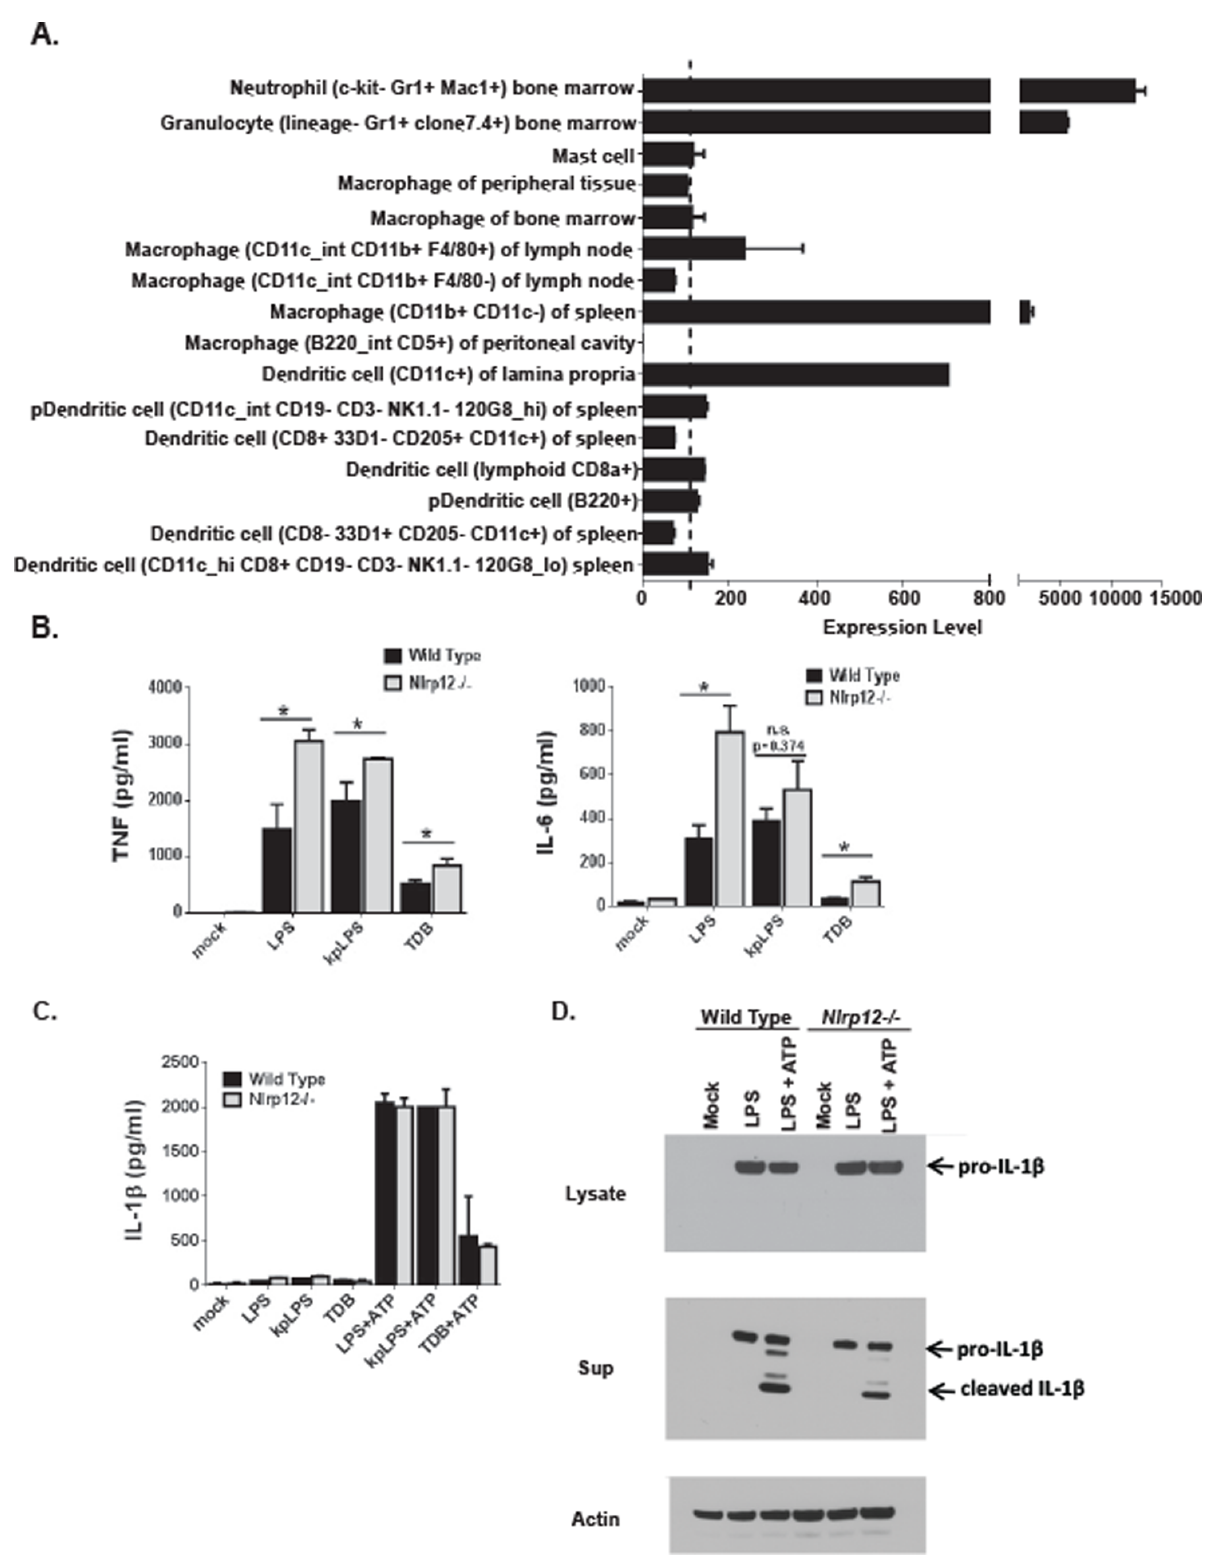
Figure 1. Dendritic cell stimulation with PAMPs associated with E.coli , K.pneumoniae and M.tuberculosis . A) Nlrp12 expression in relevant immune system cell types was compiled using a publically accessible microarray meta-analysis search engine (Nextbio website. Available: http://www.nextbio.com/b/search/ba.nb. Accessed 2013 March 11). B) Primary bone marrow derived dendritic cells were isolated, cultured and stimulated with either E. coli LPS (LPS)(50 ng/ml), K. pneumoniae LPS (kpLPS)(50 ng/ml) or trehalose-6,6-dibehenate (TDB; a synthetic analog of TDM from M. tuberculosis )(50 m g/ml). The levels of TNF a and IL-6 were evaluated in the supernatants following 4 hours of stimulation. Experiments were